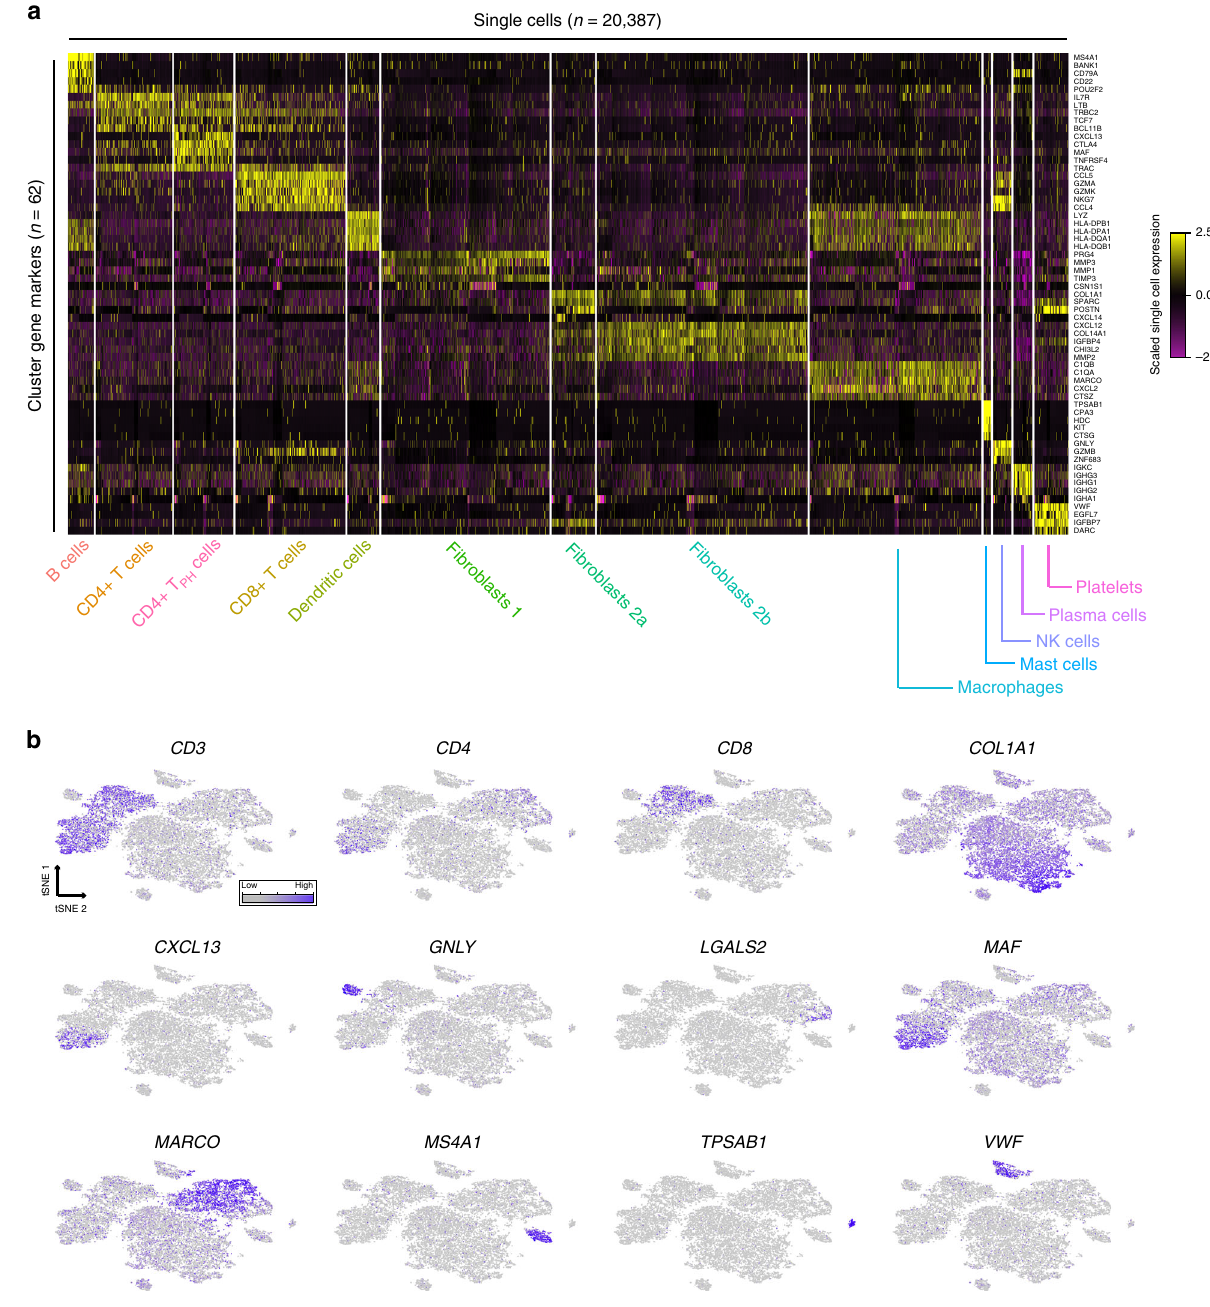
Fig. 3 Transcriptomic markers of gene expression for individual clusters. a Single cell expression heatmap displaying up to fi ve transcriptomic markers for each cluster, based on differential expression testing. b Gene expression for canonical marker genes, overlaid on the tSNE visualization. A list of transcriptomic markers for each cluster is provided in Supplementary Data